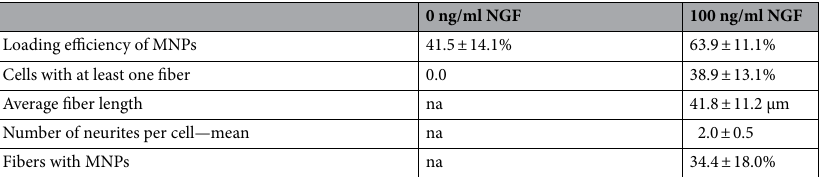
Table 2. Cellular MNP loading and responsiveness to NGF in PC12 cells. One day after scrape-loading, cells were kept in proliferation medium without NGF (control) or in differentiation medium containing 100 ng/ ml NGF for two days followed by analysis. Numbers are given as means ± SEM of four (without NGF; 378 cells were counted) or five (with NGF; 238 cells were counted) independent experiments ( na not